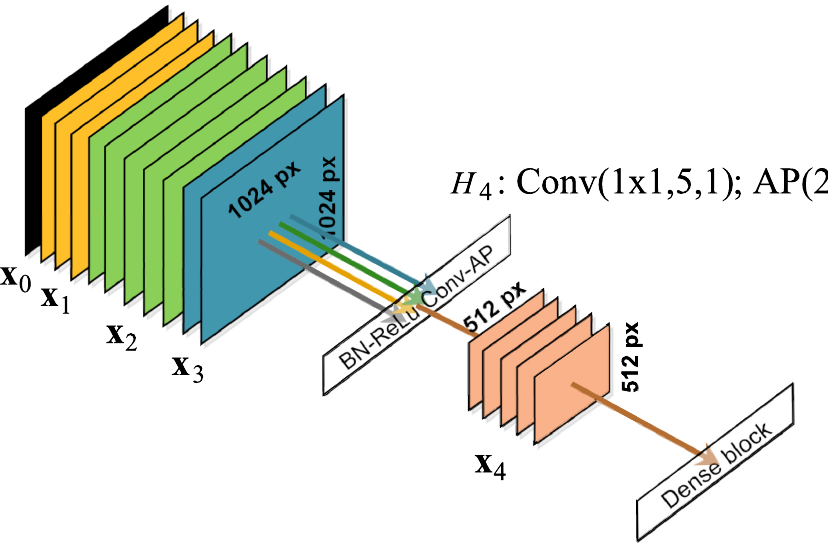
Fig 5. Layout of a transition layer. Primary, transition layers reduce spatial resolution of the feature maps x to reduce the number of parameters of the network. They are placed behind dense blocks. In this case, the transition layer is placed behind the dense block from Fig 4. The input of the network x 0 and the feature maps x 1 , x 2 , x 3 are catenated and processed by the non-linear transformations H 4 ( � ). The transformation is a composite function which consists of the batch normalization (BN), the rectified linear unit (ReLU), the convolution (Conv) and the average pooling (AP), respectively. Five convolution filters ( f = 5) of height and width 1 × 1 px ( h = w = 1) with stride one (s = 1) are used. The number of the convolution filters f controls the number of feature maps produced by the transition layer, i.e. depth of the feature maps x 4 is five in this case. Pools 2 × 2 px and stride 2 are used in AP. Thus, the original data of spatial resolution 1024 × 1024 px are reduced to 512 × 512